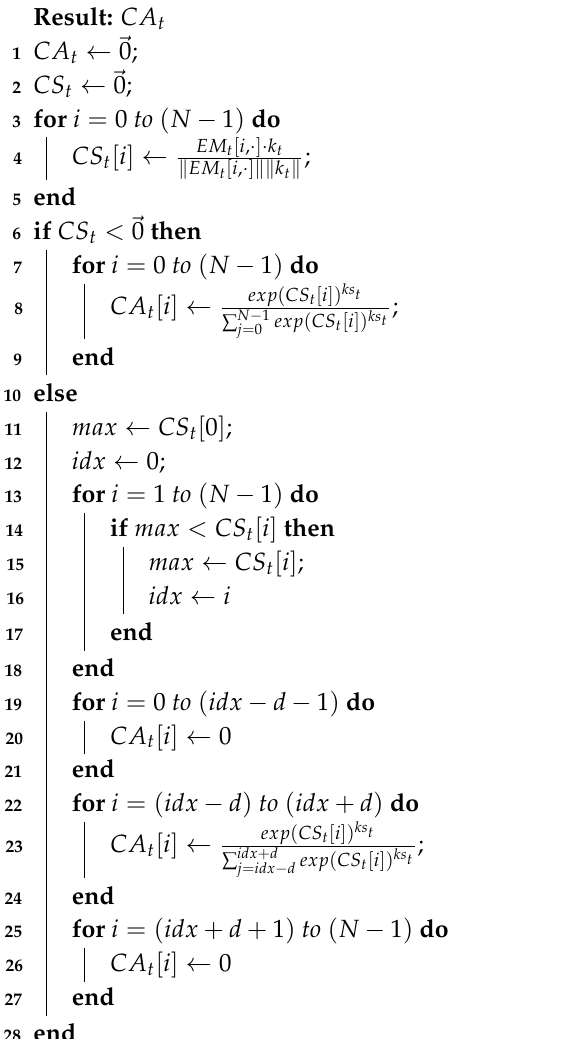
Algorithm 1: Proposed LCA procedure Data: EM t , k t , ks